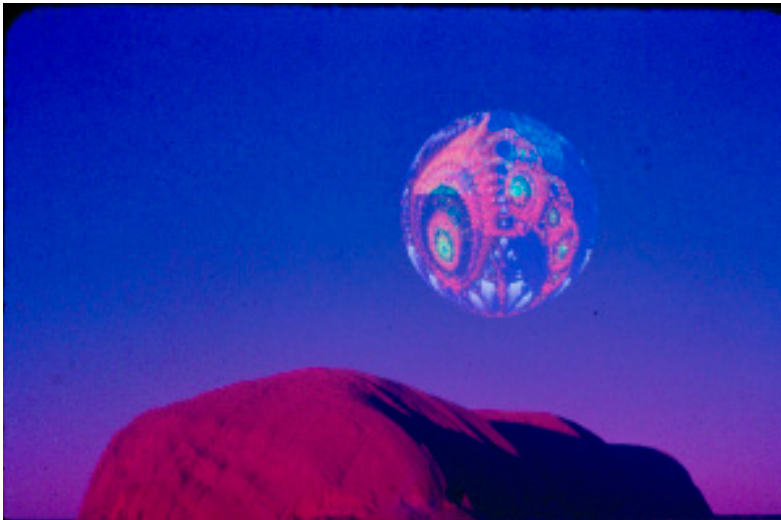
Figure 24. One of Ostoja’s landscapes with CGI. Published with permission. Image courtesy of the State Library of South Australia. SLSA: PRG919/21/159.